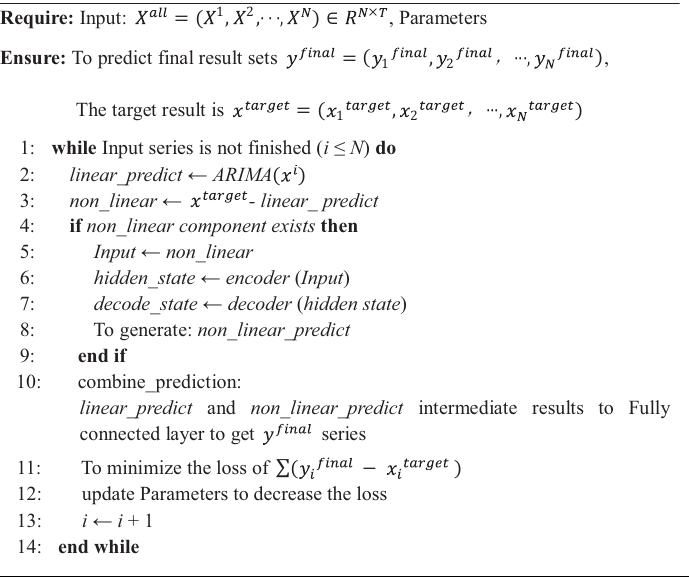
Algorithm 1 RCSNet training